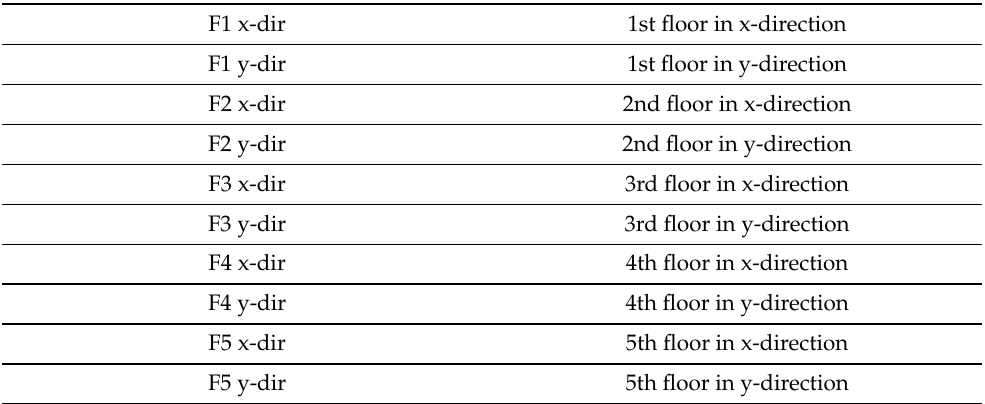
Table 4. Lausanne Malley: Failure location divided by units, floors and